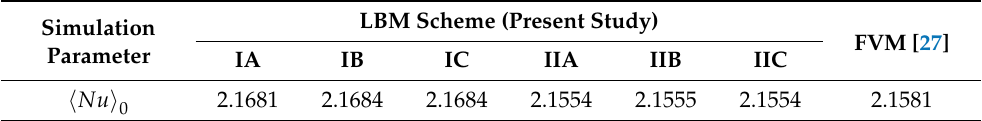
Table 4. Average Nusselt number at the hot wall (cid:104) Nu (cid:105) tem from distinct LBM schemes during the steady-state period of the flow for aspect ratio = 1, Ra = 10 4 , Pr = 0.71, τ υ = 0.6, and Ma = 0.1 compared with the outcome of the finite volume method (FVM)